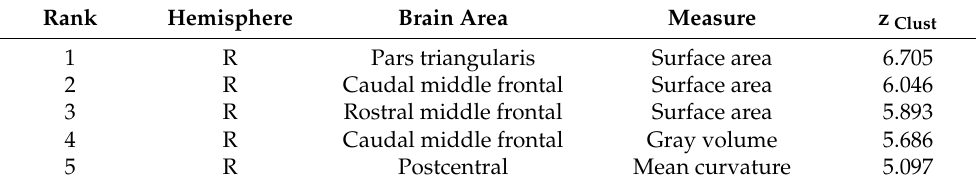
Table 4. Top-ranking brain features of clustering coefficient (Cluster II).